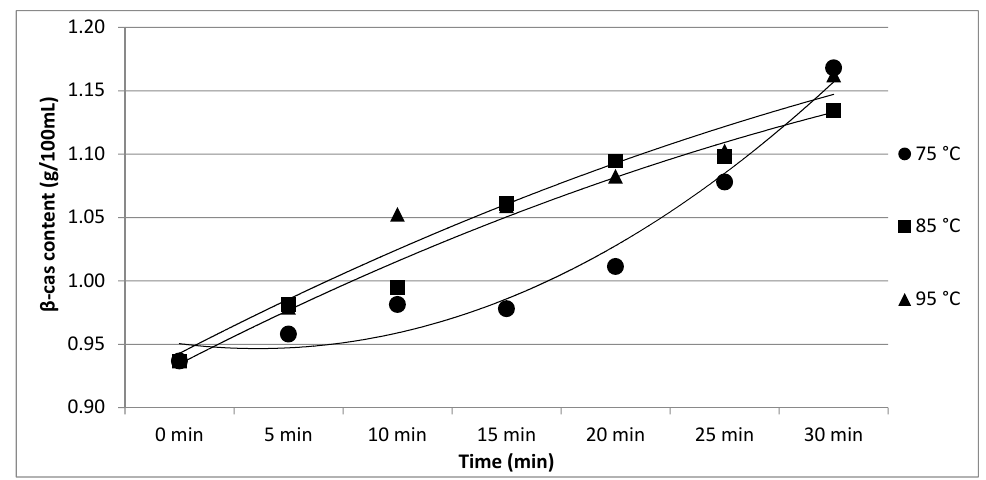
Figure 7. Effect of heating temperature and time on β -cas content. Equations: 75 °C (y = 0.0075x 2 − 0.0259x + 0.9688; R 2 = 0.9667), 85 °C (y = − 0.0019x 2 + 0.0479x + 0.8884; R 2 = 0.9725), 95 °C (y = − 0.0017x 2 + 0.0479x + 0.8966; R 2 = 0.9545).